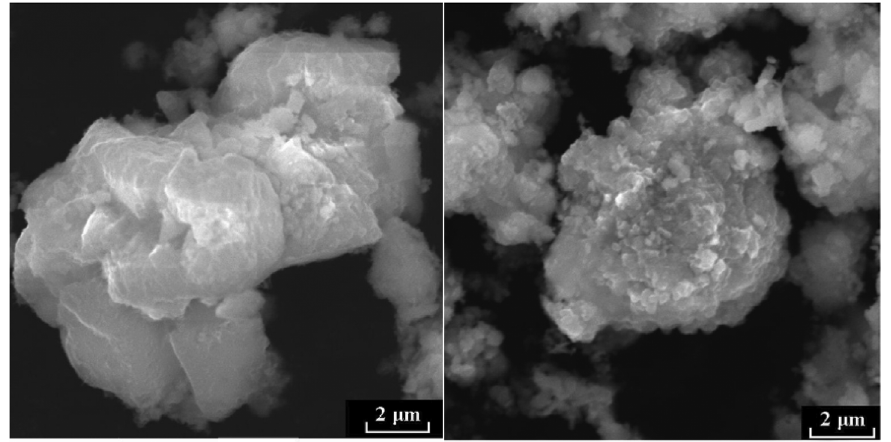
Figure 8: SEM analysis results of samples before (a) and after (b) microwave roasting.